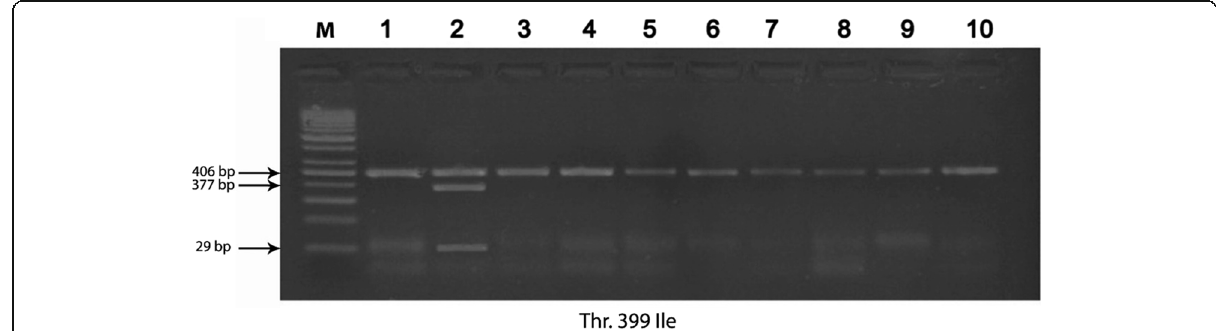
Fig. 2 Using RFLP restriction enzyme (HinfI), the identified bands after transillumination by UV transilluminator. From left to right: M (DNA marker), DNA ladder (lane 1-10), and 50 bp ladder. Lanes (1, 3, 4, 5, 6, 7, 8, 9, and 10) show wild genotype (Thr/Thr). Lane (2) shows a heterozygous genotype (Thr/Ile)